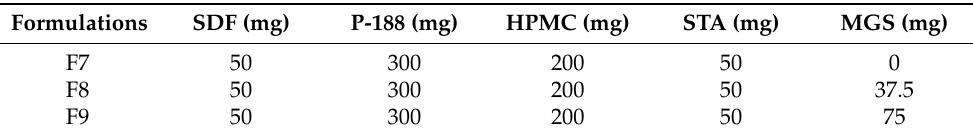
Table 5. Controlled release polymer matrices containing various drug to polymer ratios with the addition of MGS and